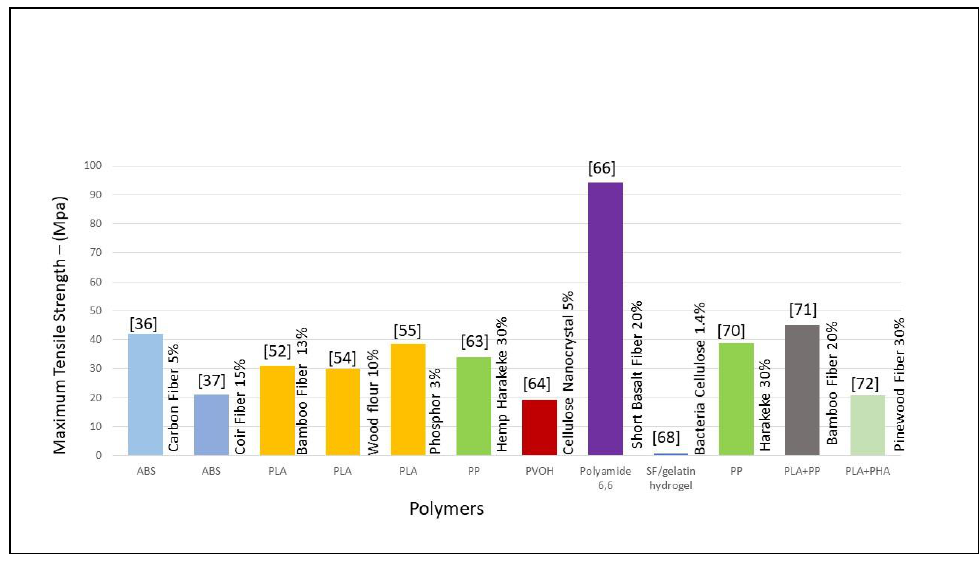
Figure 3. ( a ) The maximum tensile strength with fiber wt.% [30,34,35,38 – 42,44,47,51,62]. ( b ) the maximum tensile strength with fiber wt.% [36,37,52,54,55,63,64,66,68,70 – 72]. Osman et al. [30] used ABS with rice straw (RS) and a single-screw extruder to investigate the